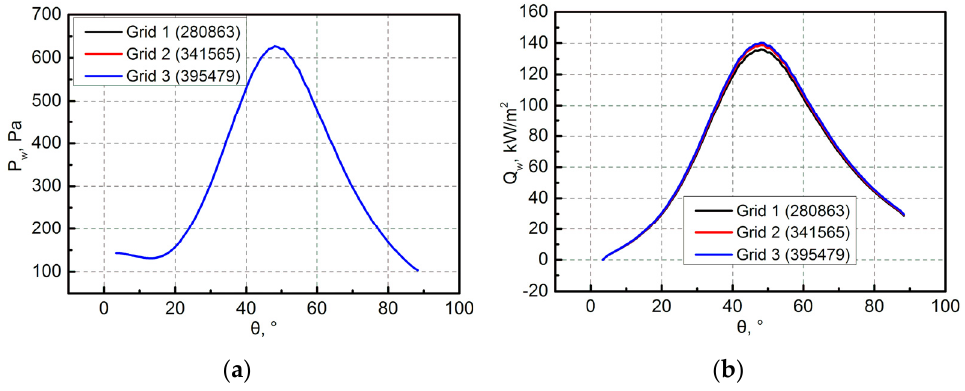
Figure 8. Grid independency analysis results: ( a ) pressure; ( b ) heat flux.